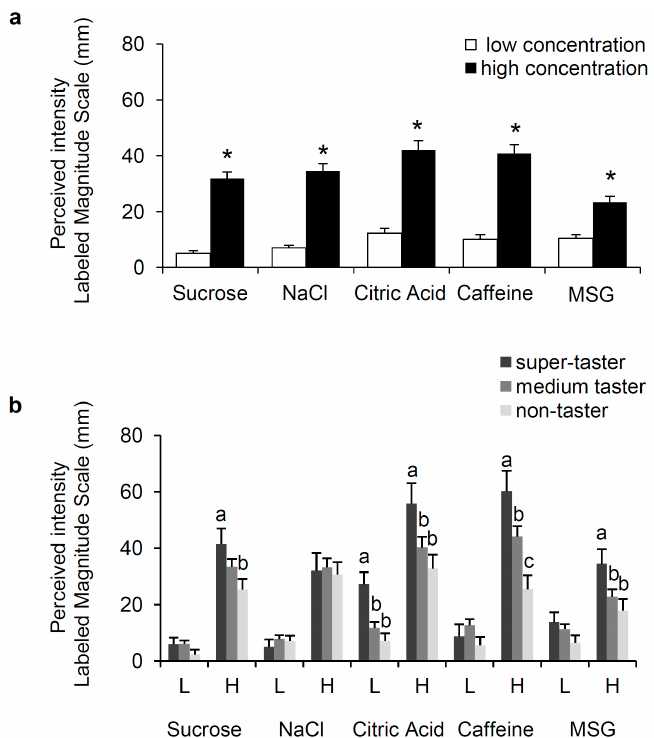
Figure 1. Mean values ± SEM of the taste intensity evoked by stimulation with two concentrations (low, L and high, H) of each stimulus (sucrose, 20 and 146 mmol/L; NaCl, 20 and 85 mmol/L; citric acid, 1.3 and 5.2 mmol/L; caffeine, 1.5 and 6.7 mmol/L; MSG, 10 and 80 mmol/L) ( a ). n = 64. The same data shown according to PROP-taster status of subjects ( b ), which was determined by the three-solution test [71] and the impregnated paper screening test [72]. Super-taster ( n = 9, all with PAV/PAV genotype of TAS2R38 locus), medium-taster ( n = 35 of which 31 had PAV/AVI and four AVI/AVI genotype), non-taster ( n = 20, all with AVI/AVI genotype). * Significant difference with respect to the corresponding value of the stimulus at low concentration ( p < 0.00011; Fisher’s LSD test, subsequent repeated-measures ANOVA). For each solution, different letters on top of bars (a, b or c) indicate significant difference ( p ≤ 0.05; Fisher’s LSD test; subsequent one-way